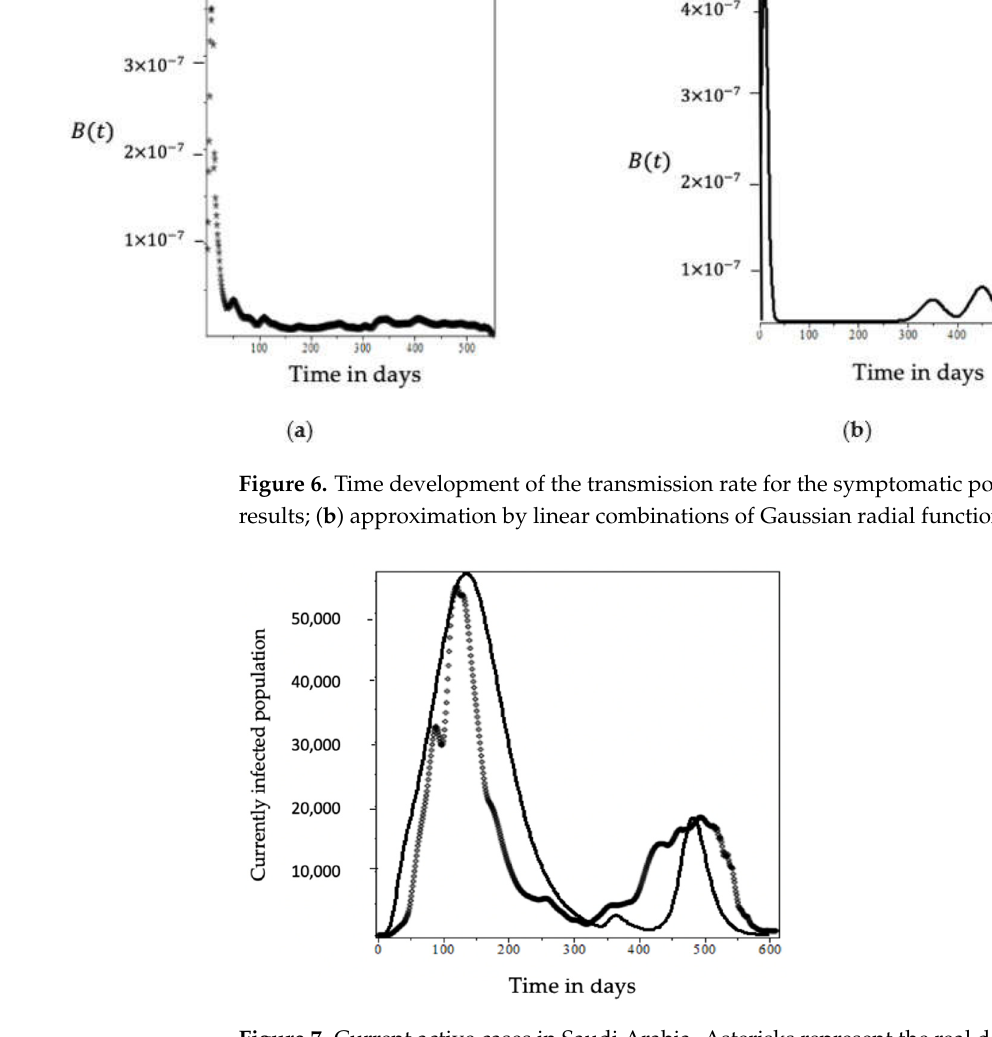
Figure 7. Current active cases in Saudi Arabia. Asterisks represent the real data, and the continuous line ( Y ( t )) represents the model prediction.